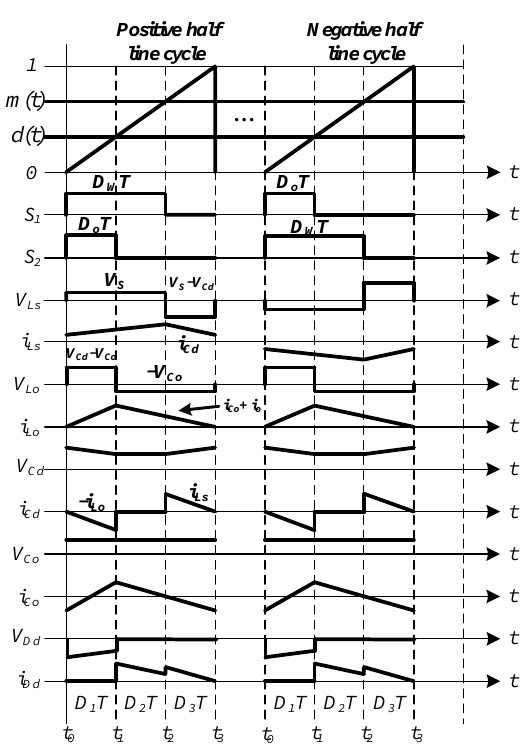
Figure 4. Control switching sequence and key waveforms in one switching period.